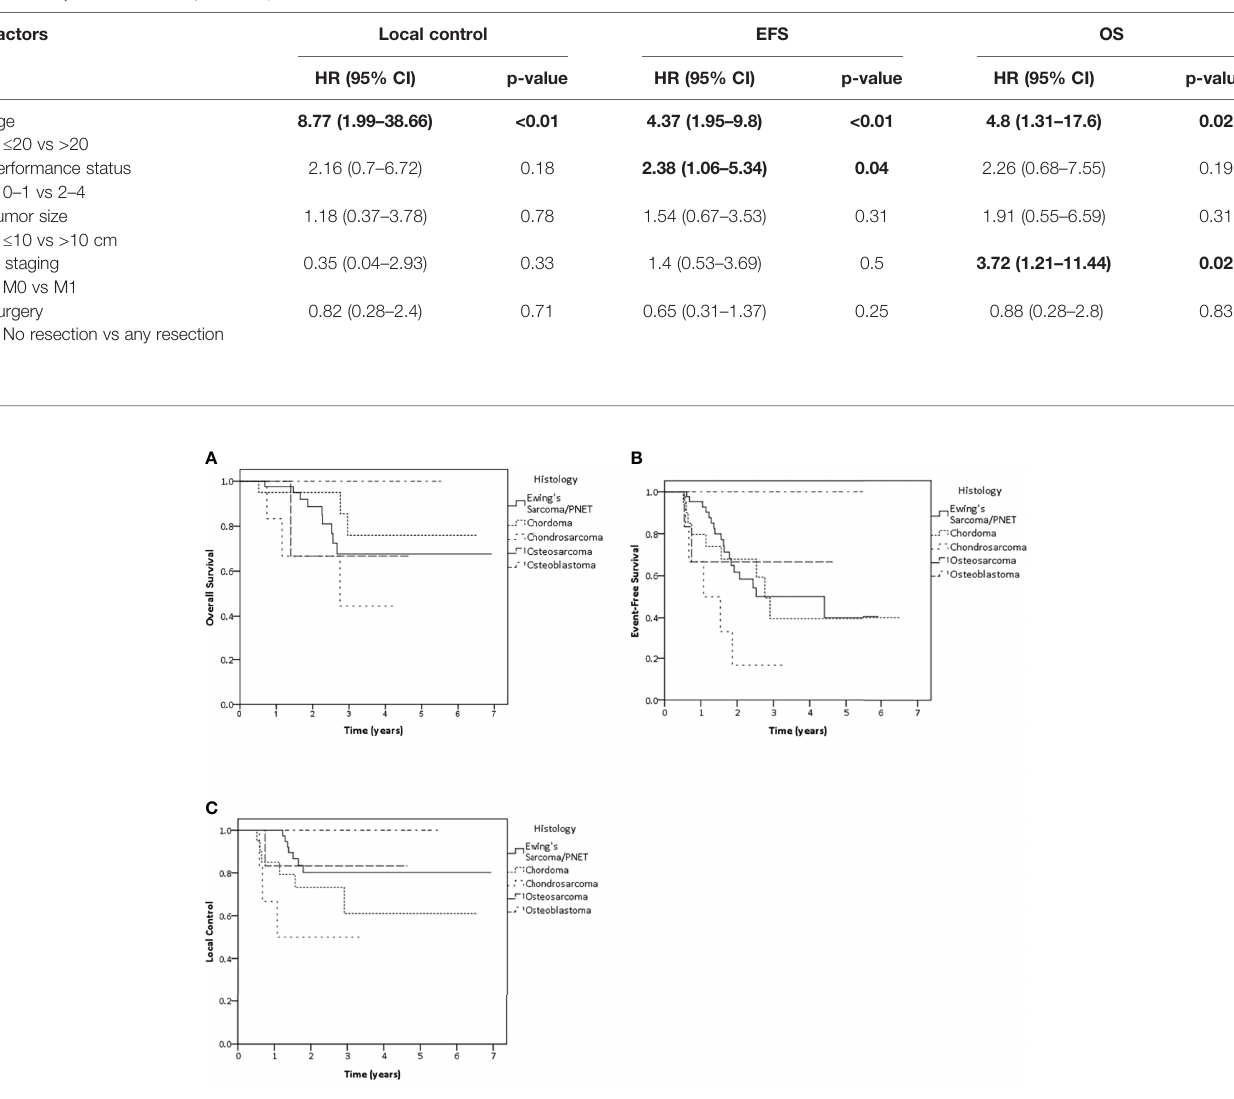
TABLE 2 | Multivariate analysis of all patients.